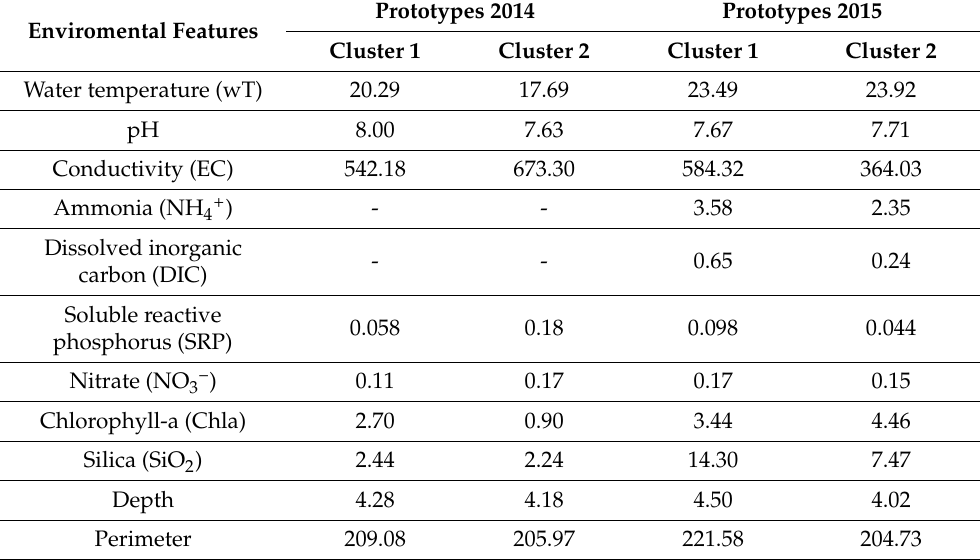
Table 3. Cluster’s prototypes of each environmental feature in the 2014 and 2015.